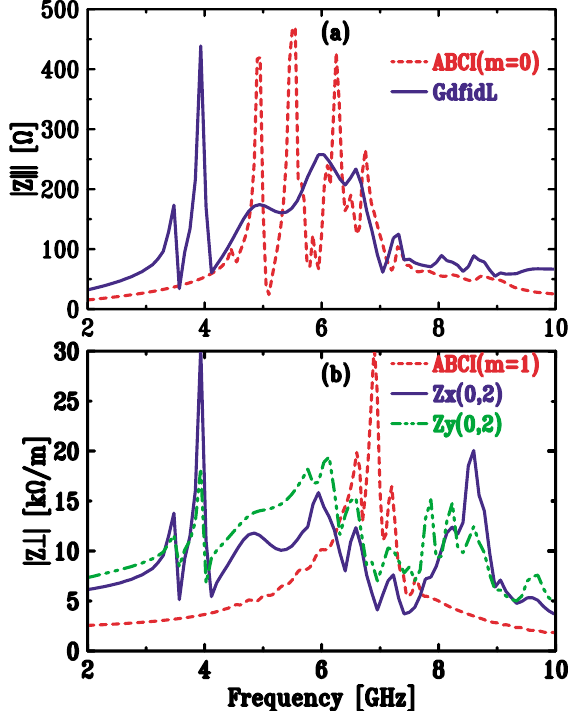
FIG. 12. (Color) (a) The longitudinal impedance calculated by ABCI , Z k (cid:8) m (cid:6) 0 (cid:9) and GDFIDL , Z k (cid:8) 0 ; 0 (cid:9) and (b) transverse im- pedance by ABCI , Z ? (cid:8) m (cid:6) 1 (cid:9) and GDFIDL Z